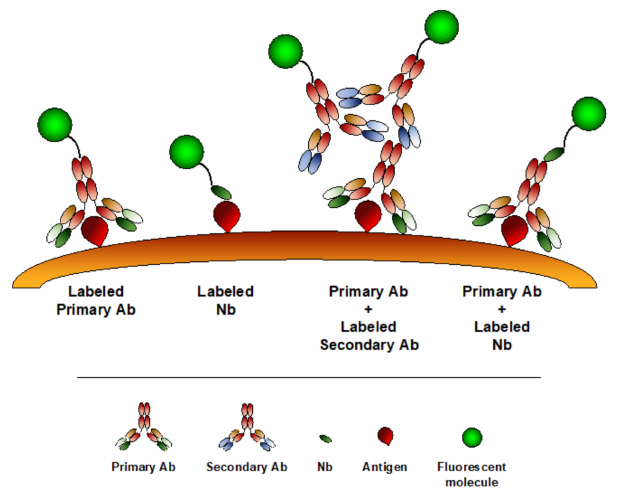
Figure 3. Nbs minimize the “linkage error.” Due to their smaller dimension compared to conventional Abs, the use of Nbs significantly reduces the distance between the antigen and the fluorophore, thus minimizing the so-called “linkage